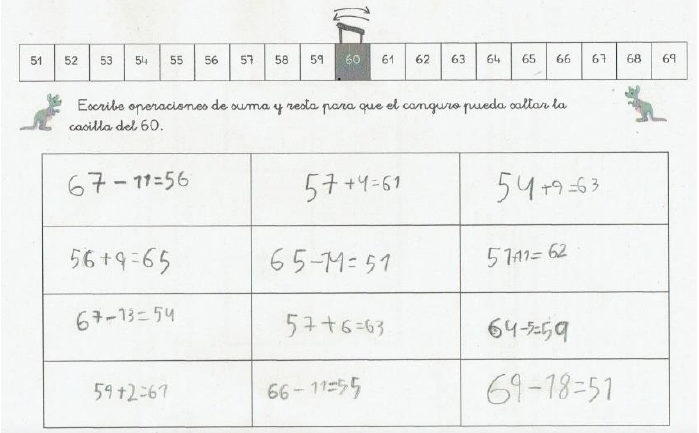
Figure 27. Kangaroo child activity 2: “Write additions and subtractions in such a way that the kangaroo overcomes number 60”.